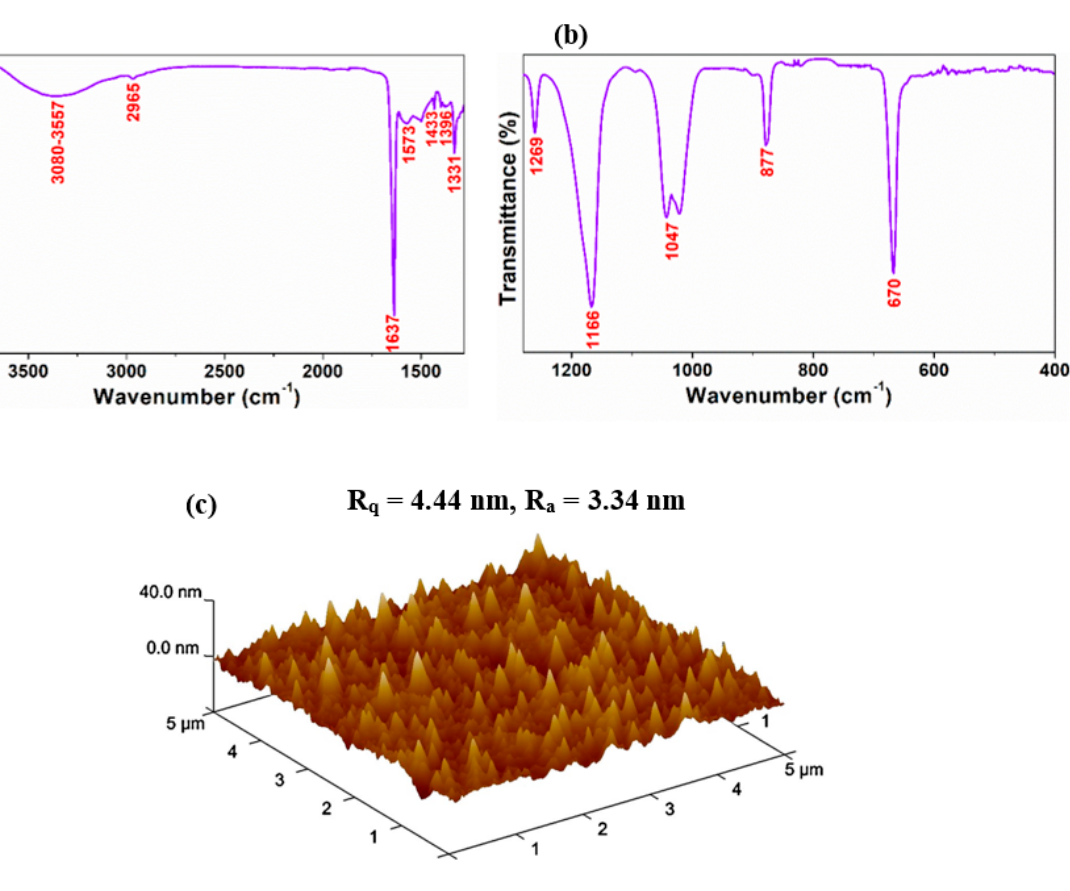
Figure 3. FTIR analysis result of the processed hair film over two certain regions ( a ) 4000 − 1280 cm − 1 and ( b ) 1280 − 400 cm − 1 . ( c ) AFM analysis results of the processed hair film.